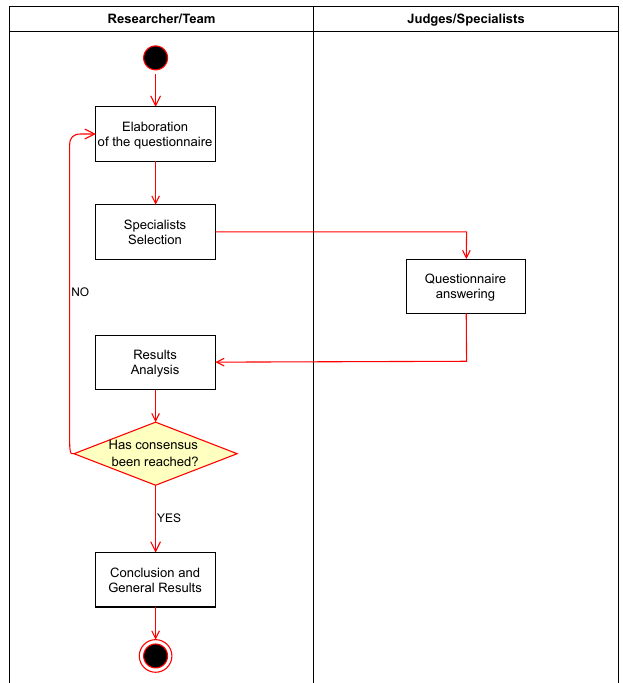
Figure 10. Delphi Method Activity